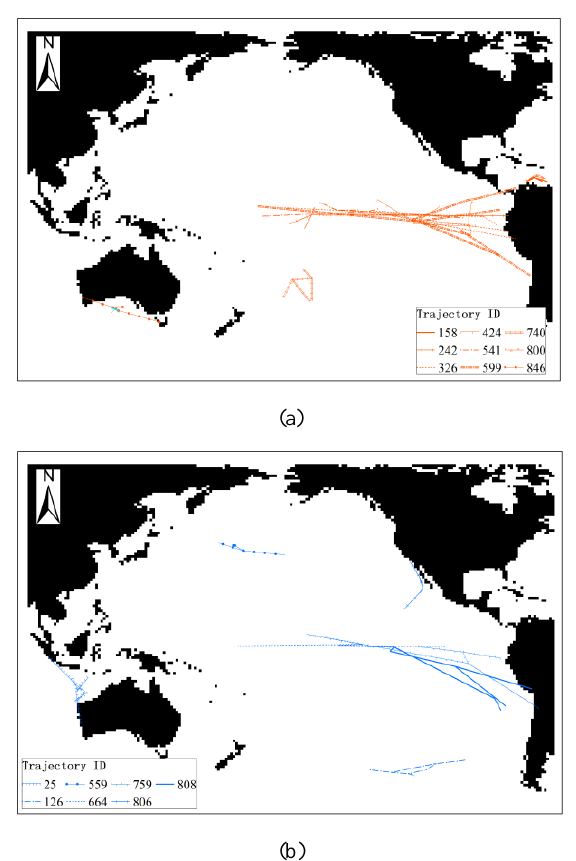
Figure 6. Clustering results of SSTA complex trajectories through POSCM.